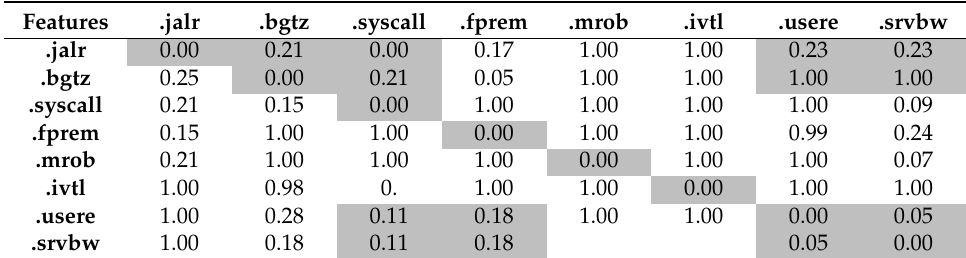
Table 6. Matrix of similarity for the DyFuCa virus.